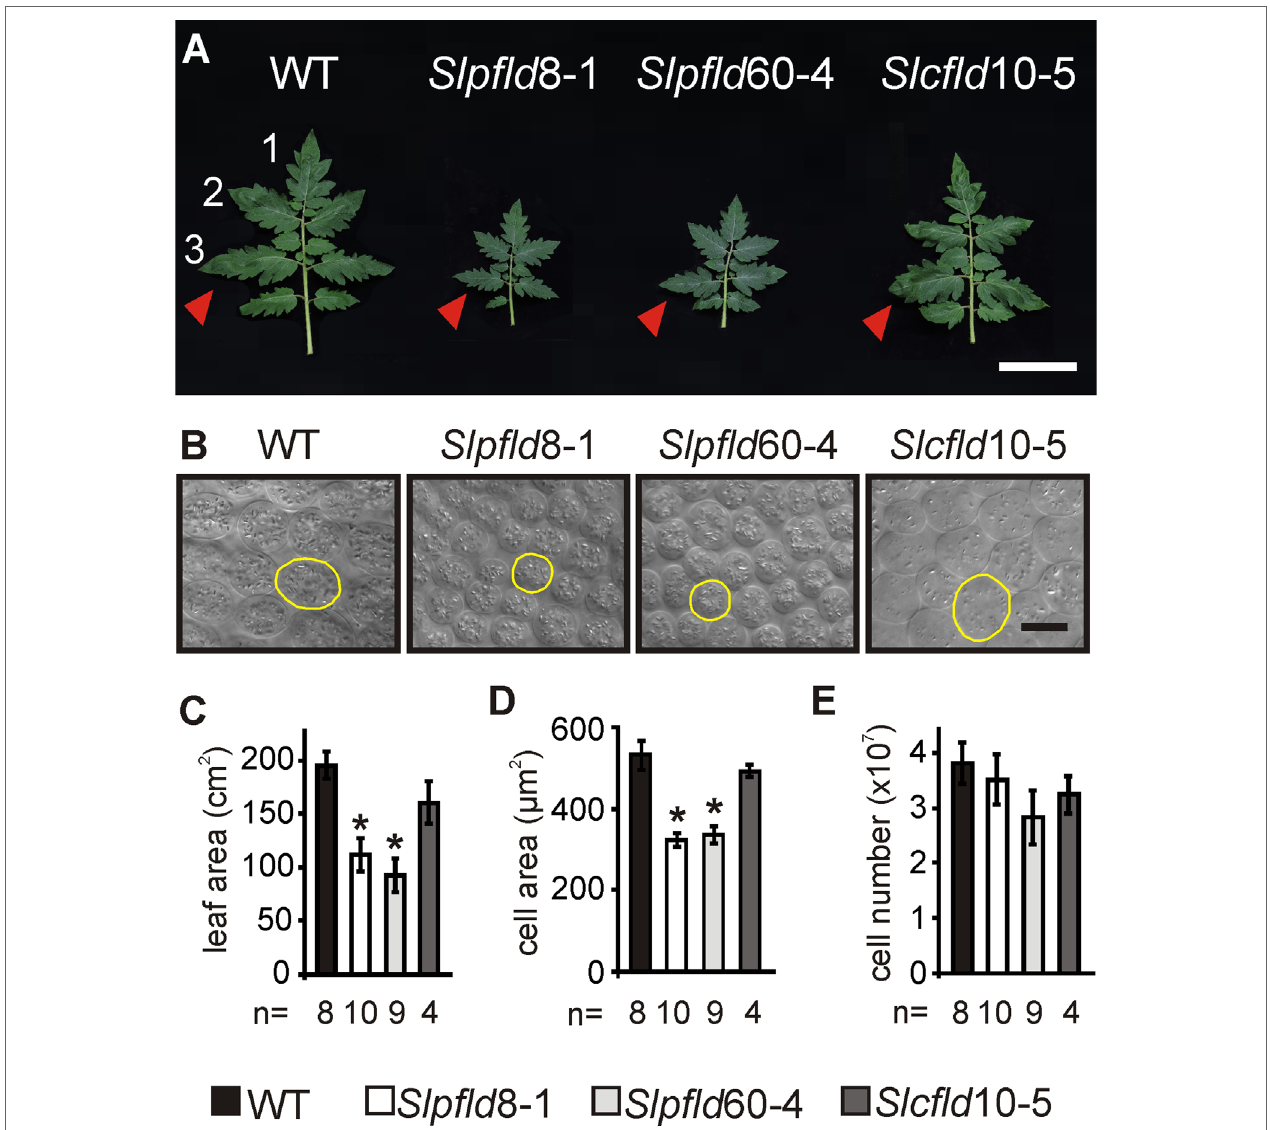
FIgURE 1 | Flavodoxin expression in chloroplasts altered tomato leaf development. (A) Phenotypes of the fourth fully expanded leaves (counting from the bottom) of plants at 30 days post-germination. Bar = 10 cm. Arrowheads indicate the third leaflets used to extract tissue samples. (B) Representative micrographs from palisade parenchyma cells. Contour of typical cells are shown in yellow. Bar = 20 µm. (C) Leaf area was determined by image analysis. (D) Cell area and (E) cell number were calculated from clarified leaf tissue (see Materials and Methods ). Data reported are means ± SEM of n biological replicates, as shown below each line. Asterisks indicate statistically significant differences ( P < 0.05) determined using one-way ANOVA and Tukey's multiple comparison